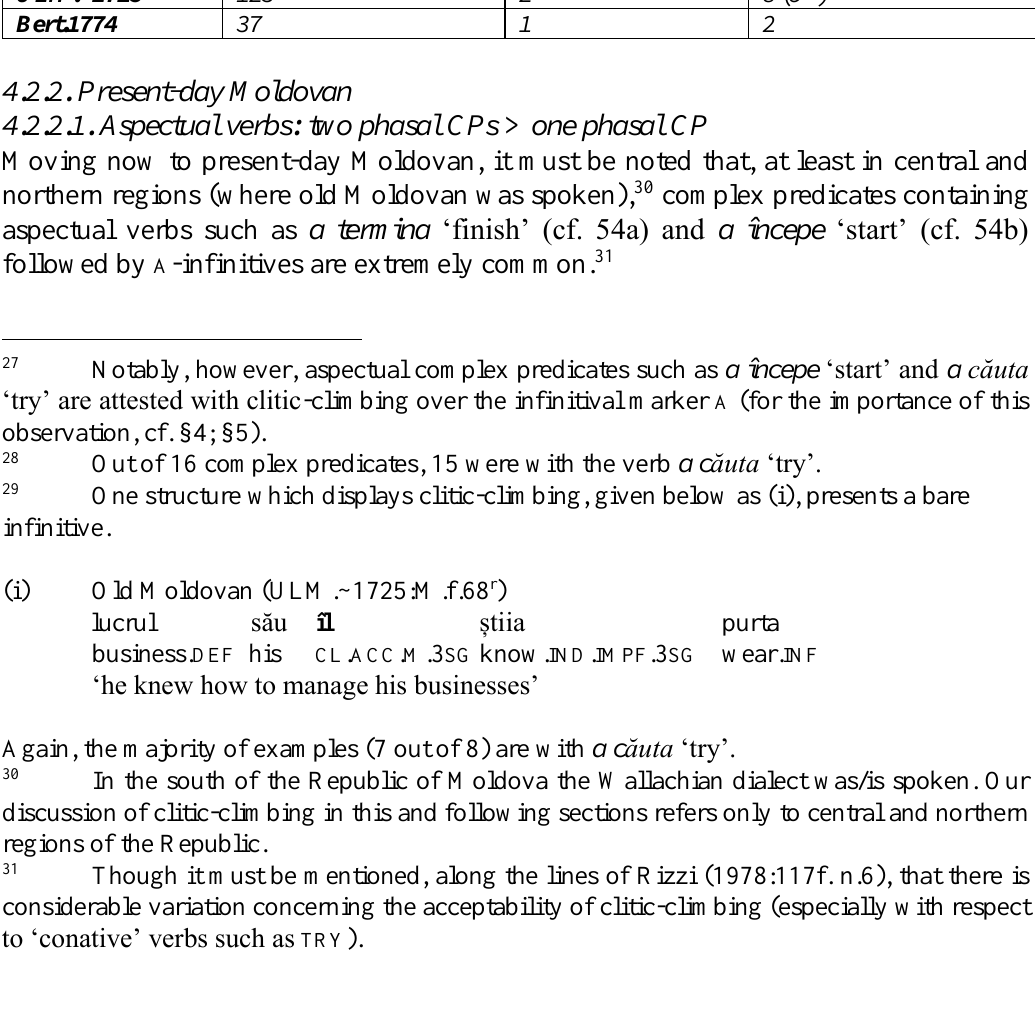
Table 4. Old Moldovan complex predicates containing infinitives functional verbs without multiple spelt out clitics CLM.1700–50 157 16 28